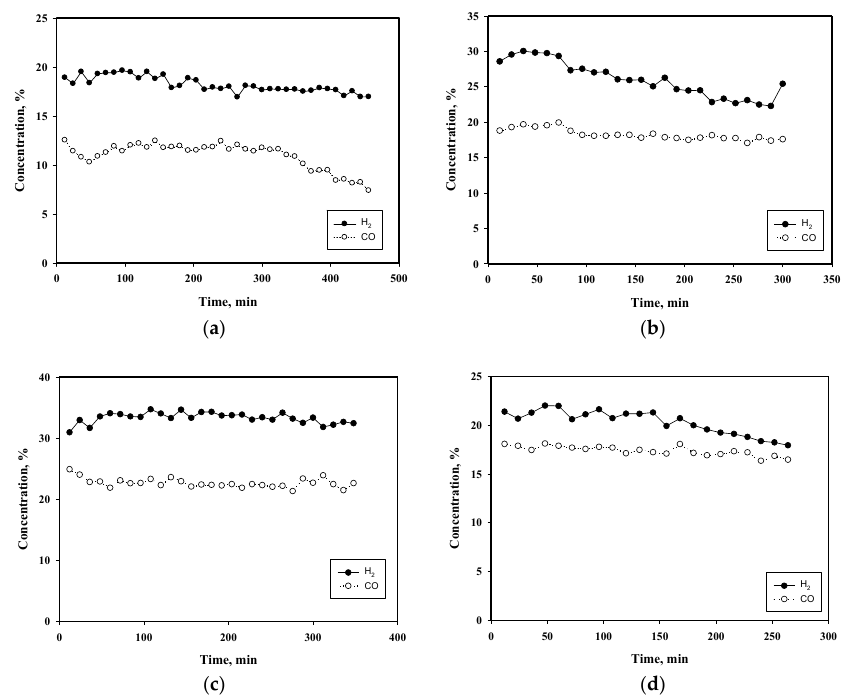
Figure 7. Concentration of H 2 and CO in the reformate gas with the auto-thermal reforming of toluene over Ni-based catalysts impregnated with various levels of CeO 2 : ( a ) 2 wt %, ( b ) 4 wt %, ( c ) 6 wt %, and ( d ) 8 wt %. CeO 2 : 2.0 wt.% CeO 2 : 4.0 wt.%